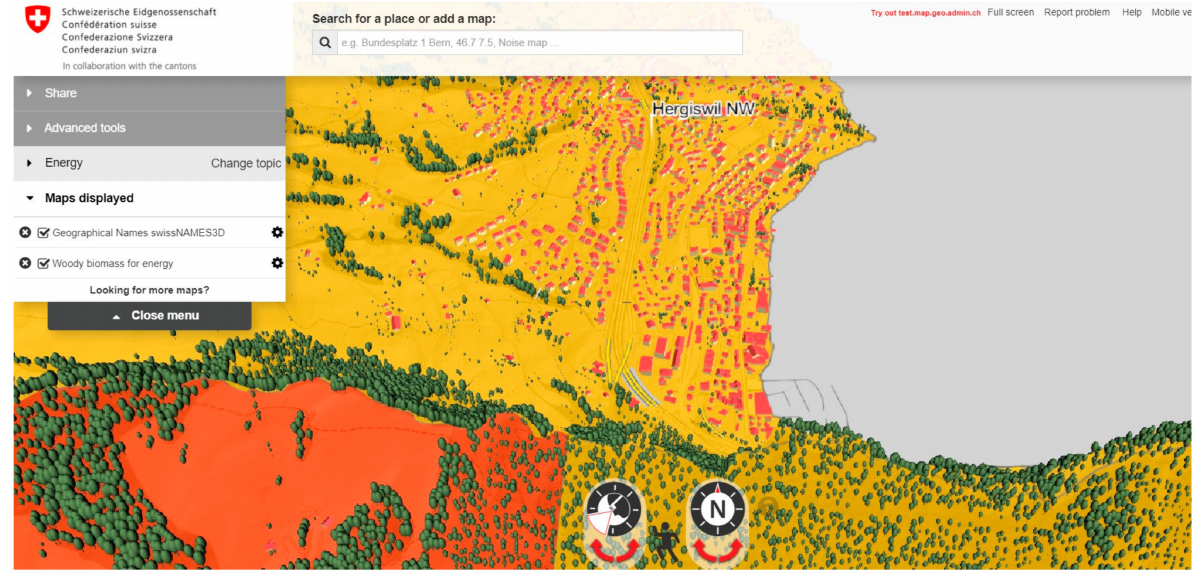
Figure 12. Woody biomass for energy in Switzerland. Source: own study based on